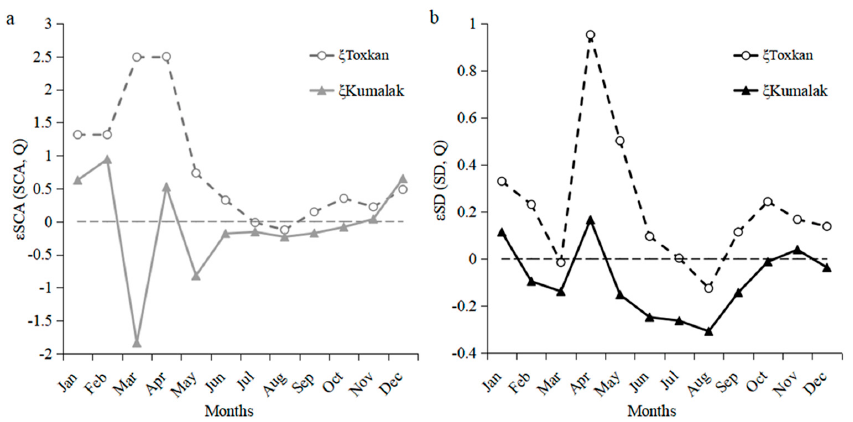
Figure 8. Monthly variations in sensitivity coefficients for ( a ) river runoff to SCA ( ε SCA ( SCA, Q )) and ( b ) river runoff to SD ( ε SD ( SD , Q )).